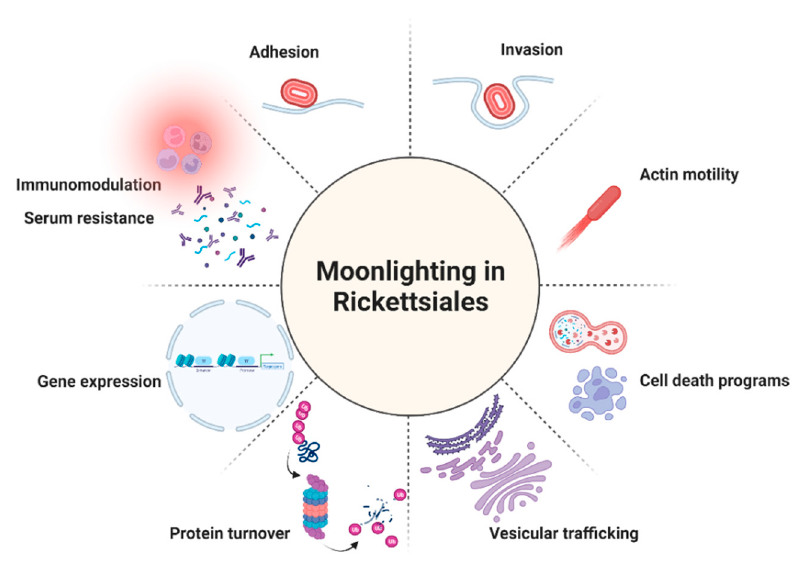
Figure 1. The multiple roles of the reported moonlighting/multitasking proteins in Rickettsiales. Created with BioRender.com.